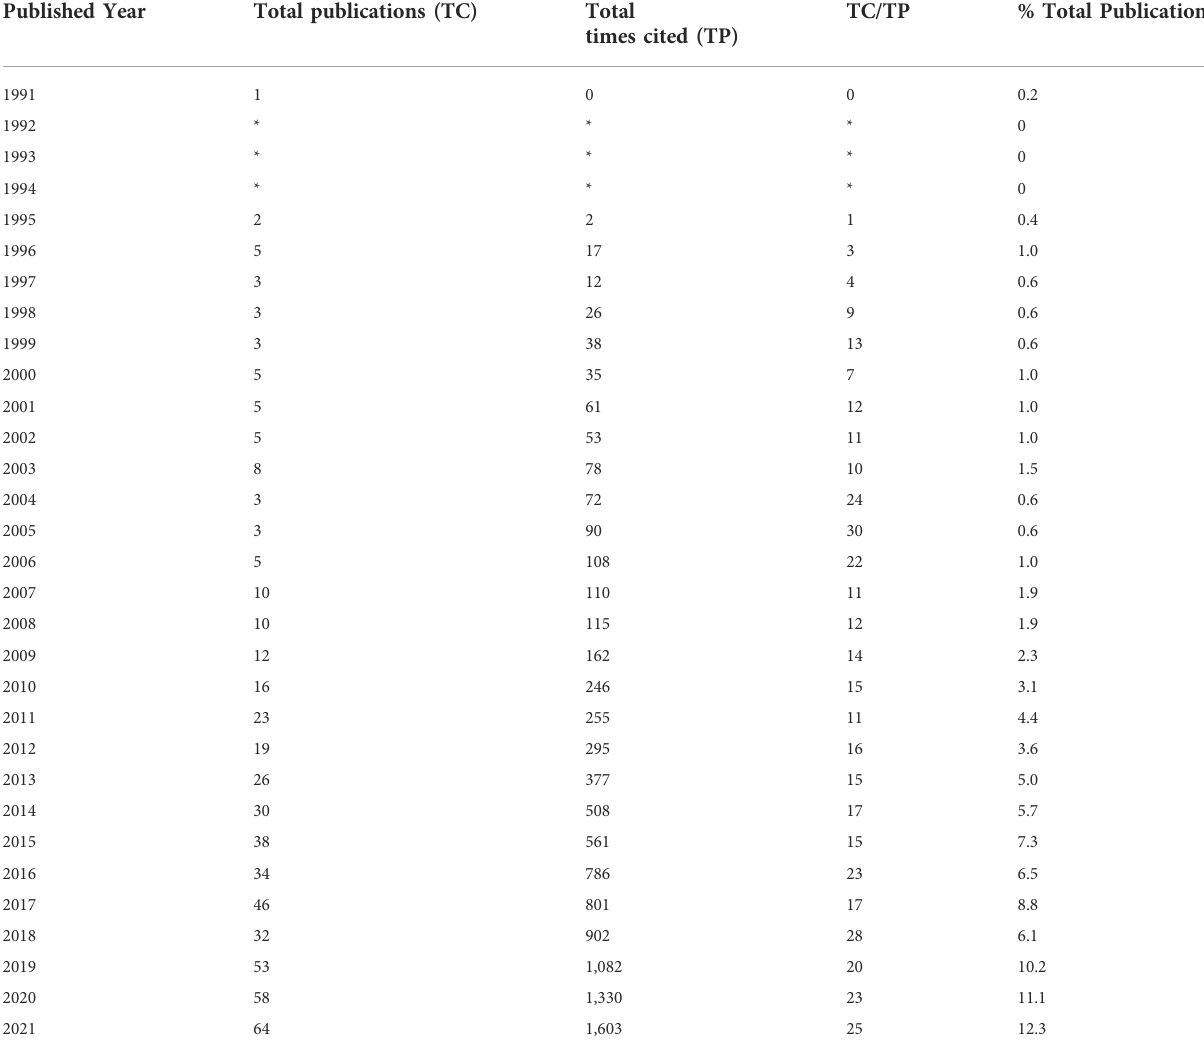
TABLE 1 Characteristics by year of publications of the RDP, from 1991 to